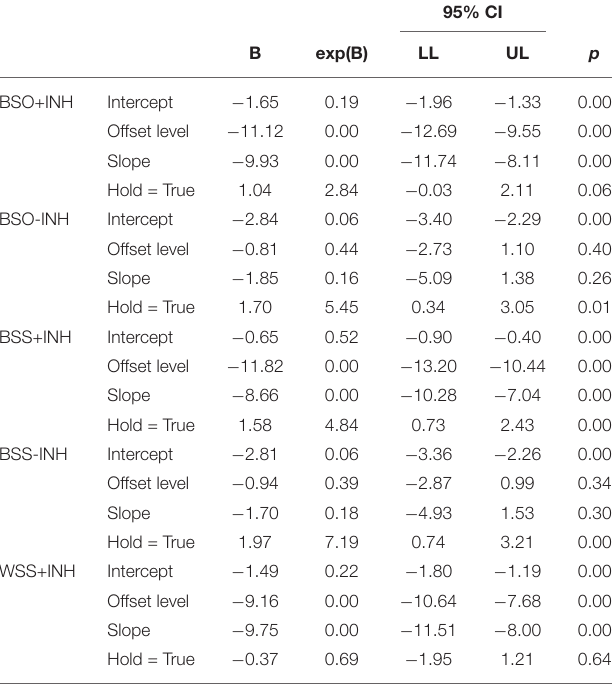
TABLE 2 | Coefficients of the exhalatory